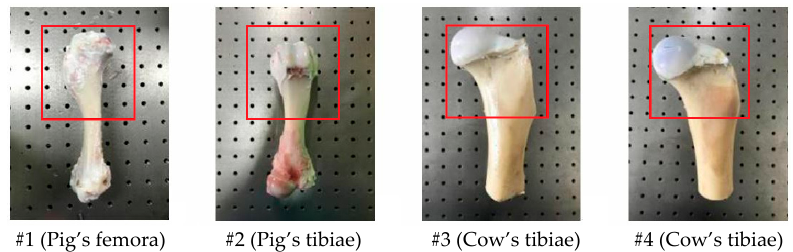
Figure 5. Wet-surface bone samples (Sample number: #1~#4).